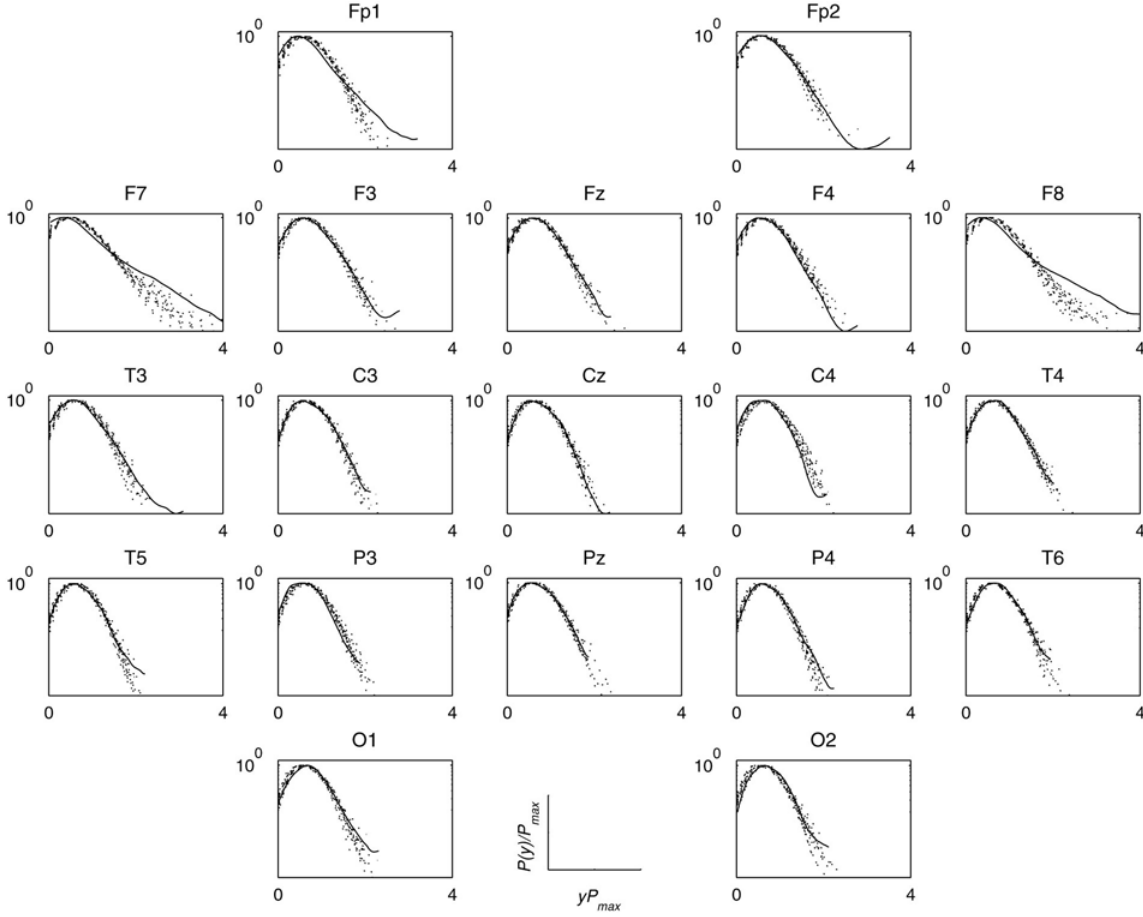
Figure 7. Surrogate analysis during visual perception. Rescaled pdfs (in the semi-log scale) of the envelope of wavelet transformed coefficients at scale a =18 for multivariate EEG signals recorded from 19 scalp locations from a participant (Vp.483) during looking at a painting and for the set (=19) of surrogates. The originals were shown in solid line and the surrogates in dotted lines. The long tail of the original pdfs in the frontolateral electrode regions (F7, F8) is conspicuously absent in the pdfs of their surrogates, indicating non-random phase correlations. Note other electrode regions produced.